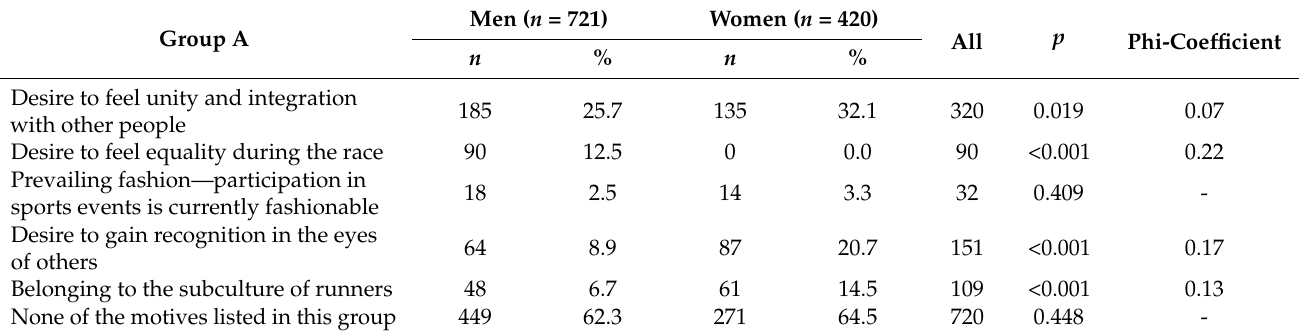
Table 2. Motives within the scope of social